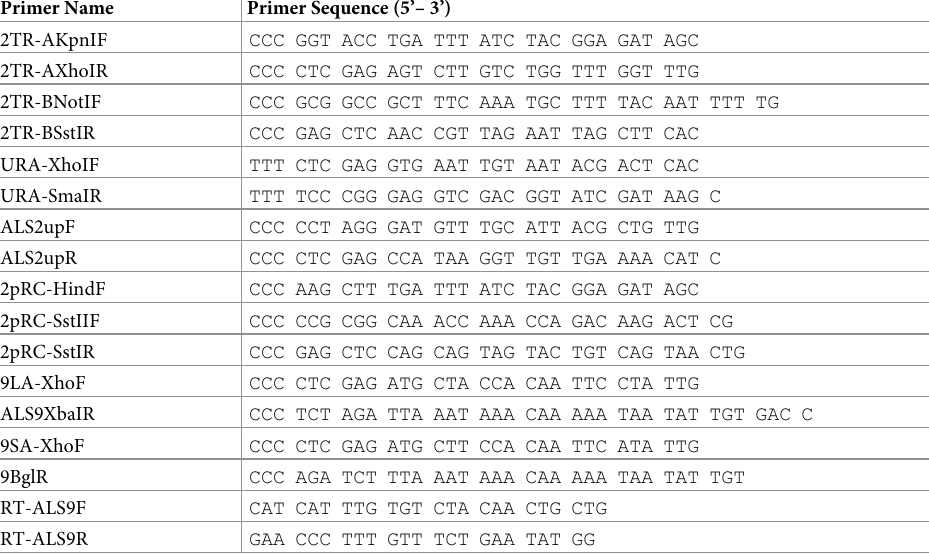
Table 1. Primer sequences used in C . albicans strain